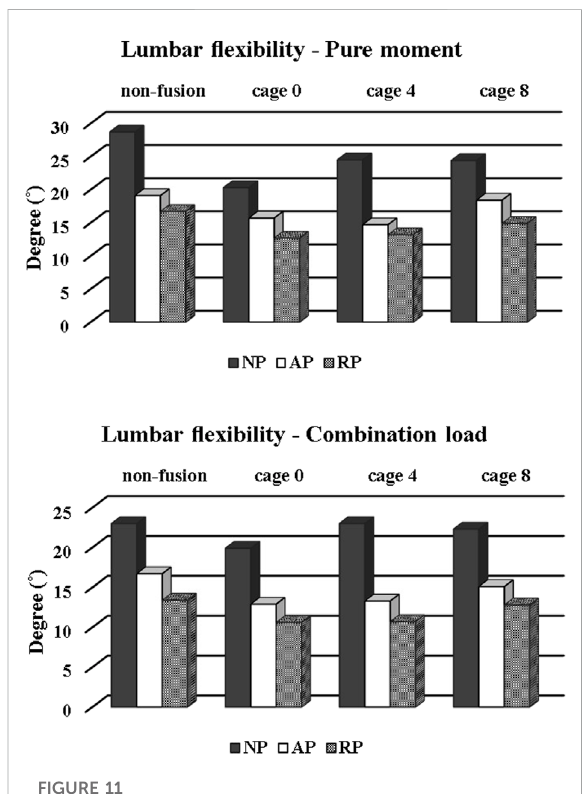
FIGURE 11 Lumbar fl exibility by cage type and pelvis